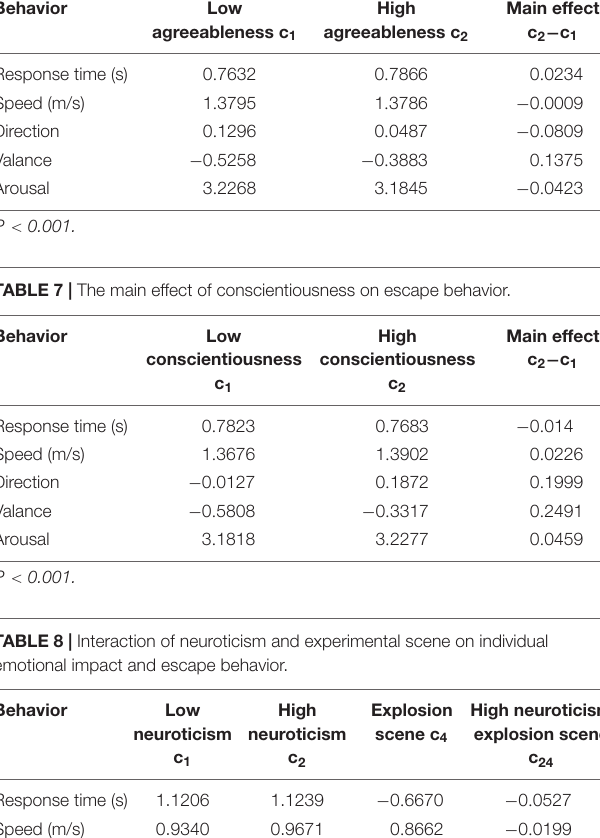
TABLE 10 | The interaction of openness and explosion scene on individual emotional impact and escape behavior.